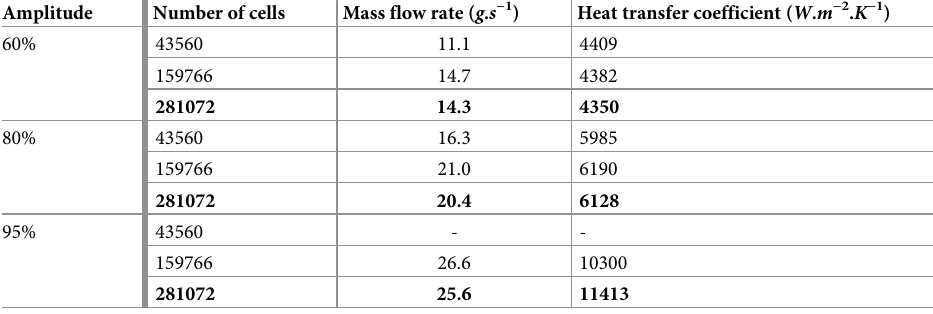
Table 2. Mesh convergence for the dynamic corrugated channel.